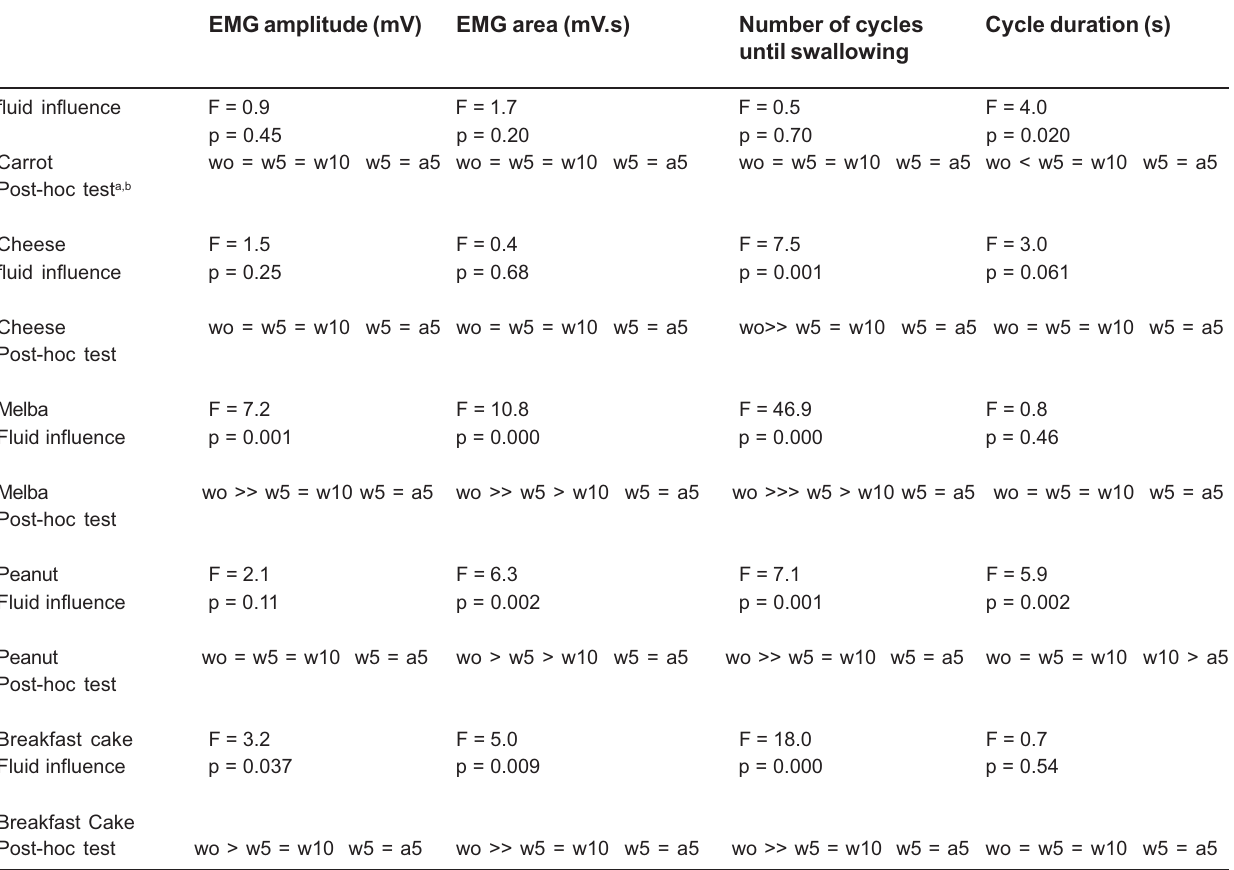
TABLE 2- F- and p-values of the effects of fluid addition on chewing physiology parameters for each of the 5